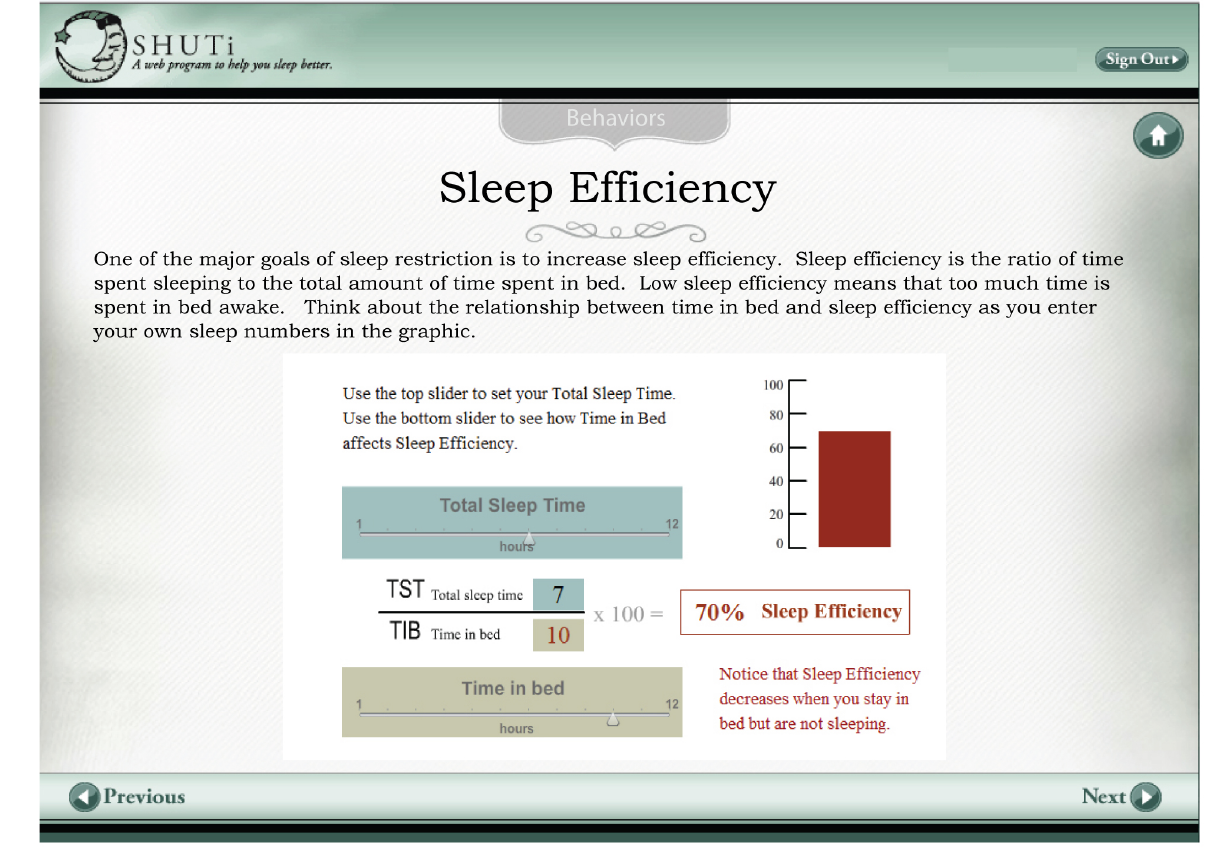
Figure 6. SHUTi (Sleep Healthy Using The Internet) sleep efficiency interaction